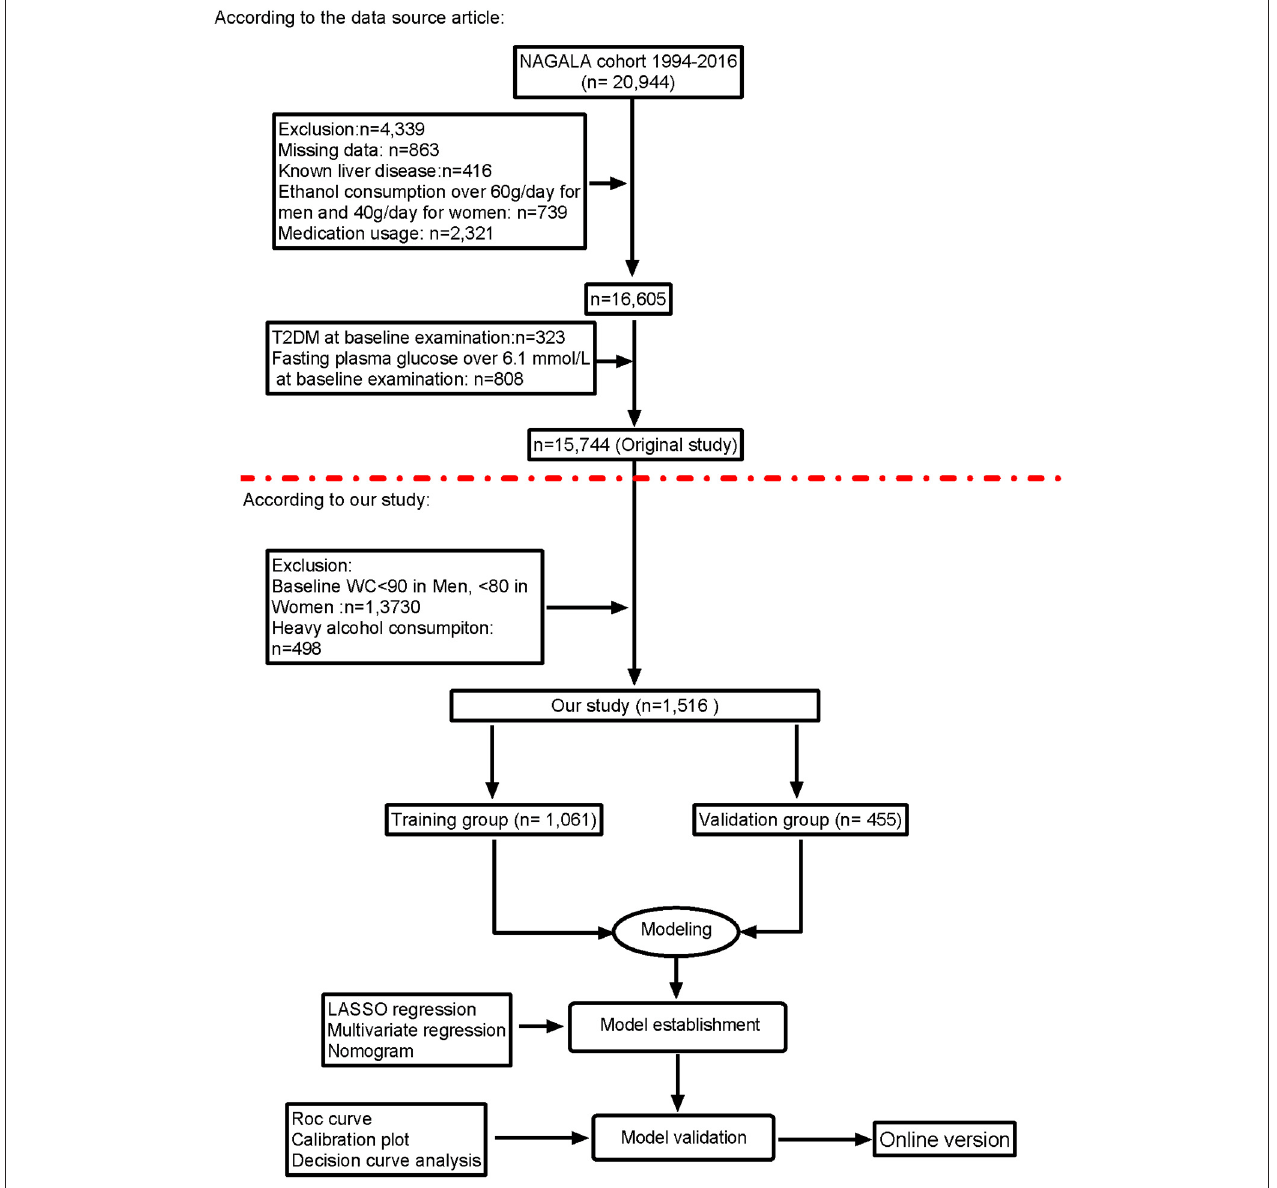
FIGURE 1 | Flow diagram of study